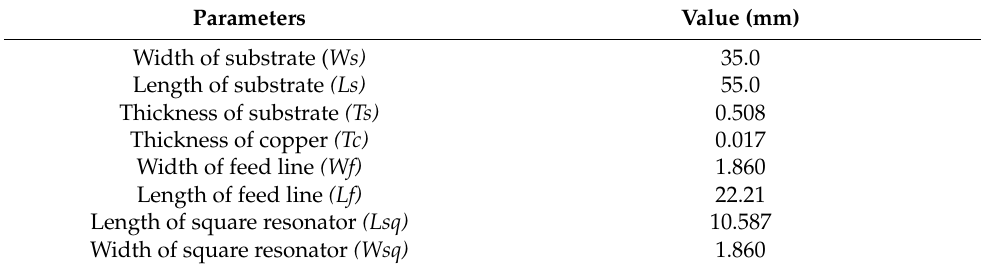
Figure 7. ( a ) Addition of feed lines on the substrate and ( b ) its S11 and S21 response. Table 2. Dimensions of the designed microstrip square ring resonator shown in Figure 7a. Parameters Value (mm) Width of substrate ( Ws)